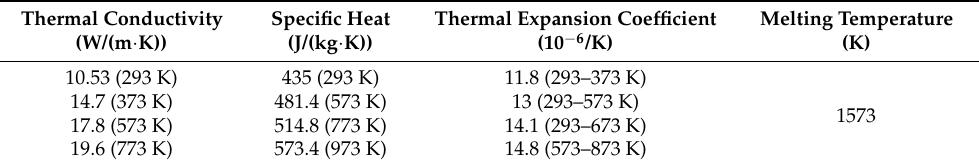
Table 1. The material properties of the Inconel 718 used in the simulations [25]. Thermal Conductivity (W/(m · K))